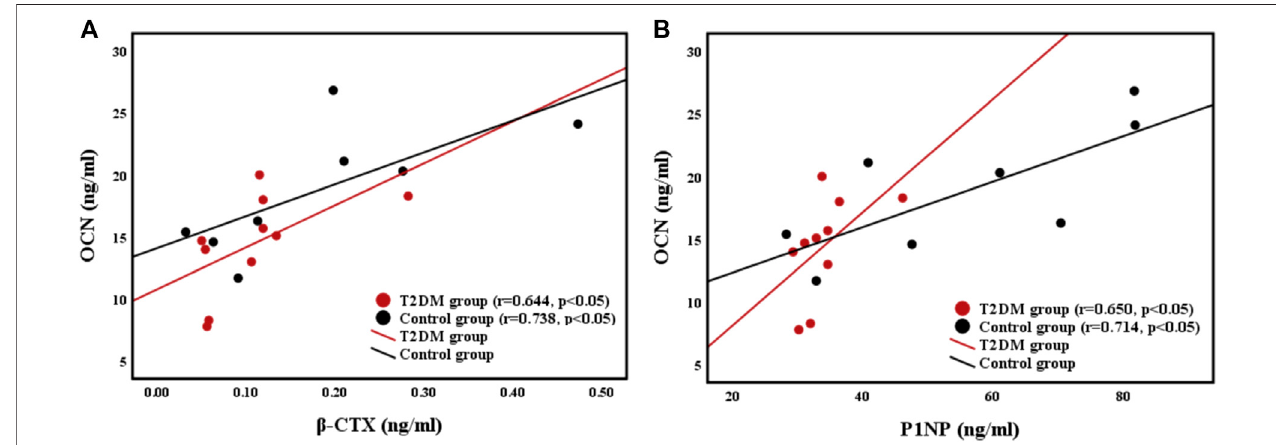
FIGURE 3 | Relationships between (A) bone resorption marker β -CTX level and bone formation marker OCN level, and (B) bone formation maker P1NP level and OCN